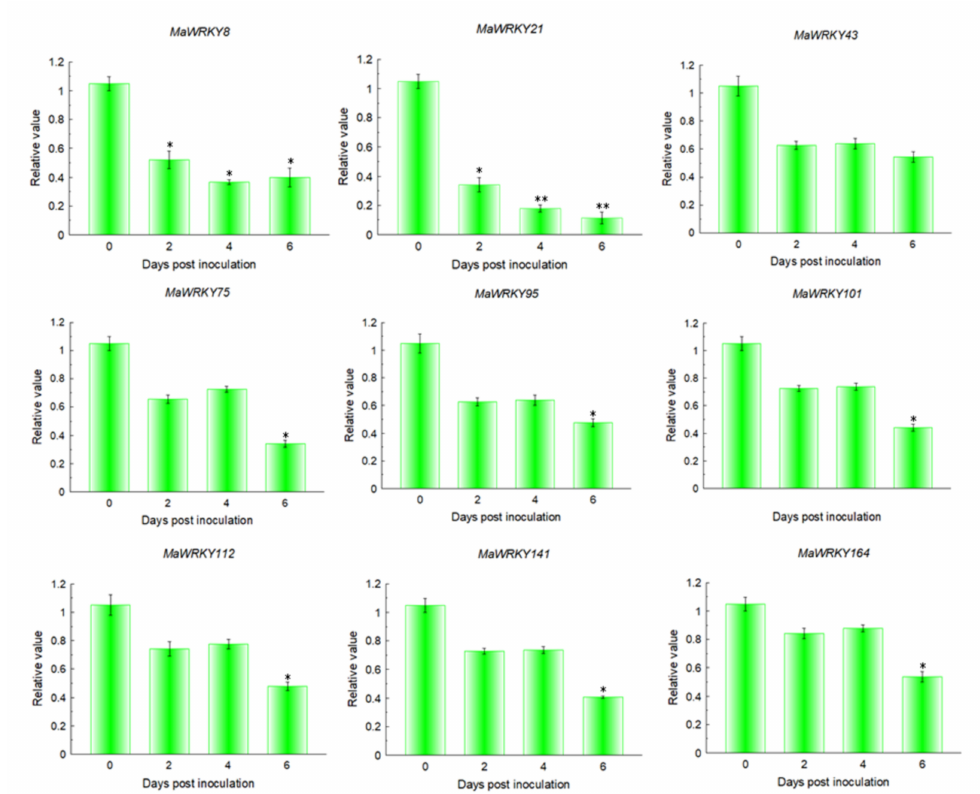
Figure 7. Expression patterns of nine MaWRKYs under Foc TR4 treatment by qRT-PCR. The data represent the mean ± standard deviation (SD) of three replicates. * and ** significantly different from the control at p < 0.05 and 0.01,